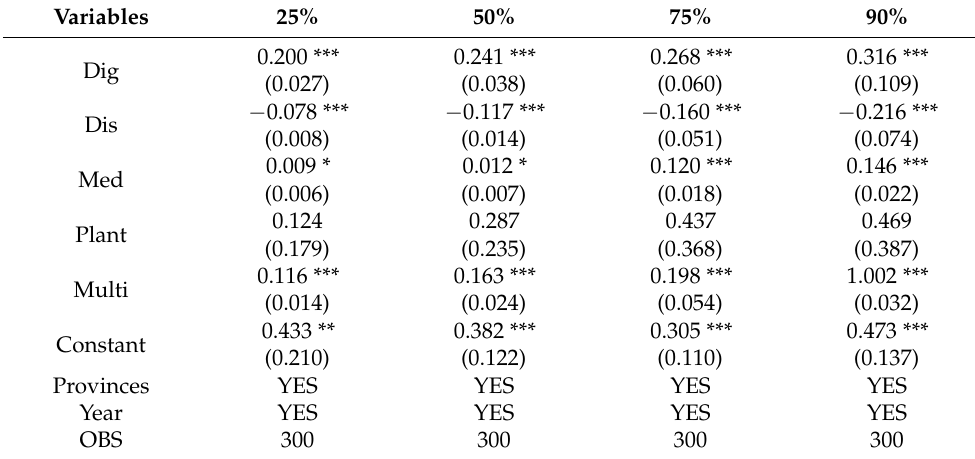
Table 7. Distribution Heterogeneity